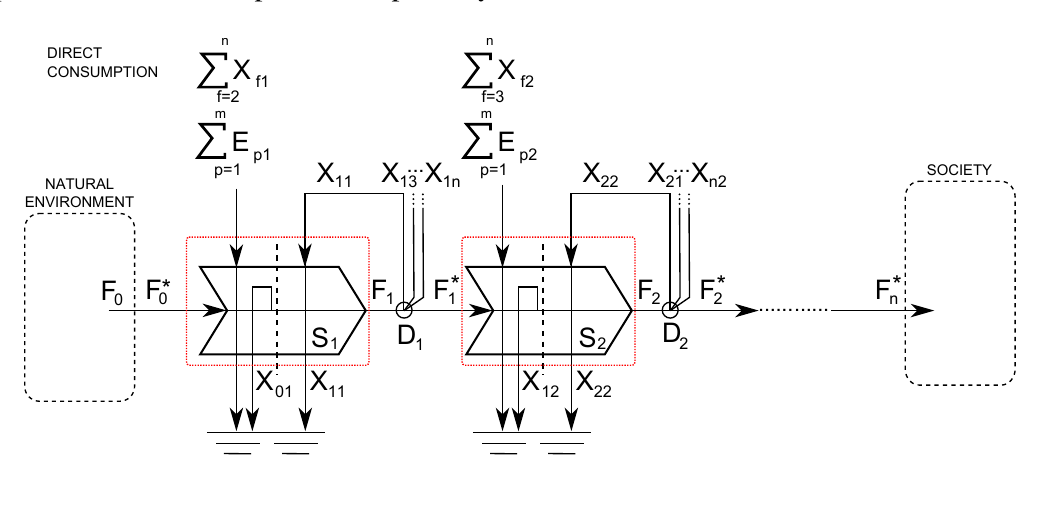
Figure 11. Energy production process with one pathway and n stages and external energy inputs from outside the production